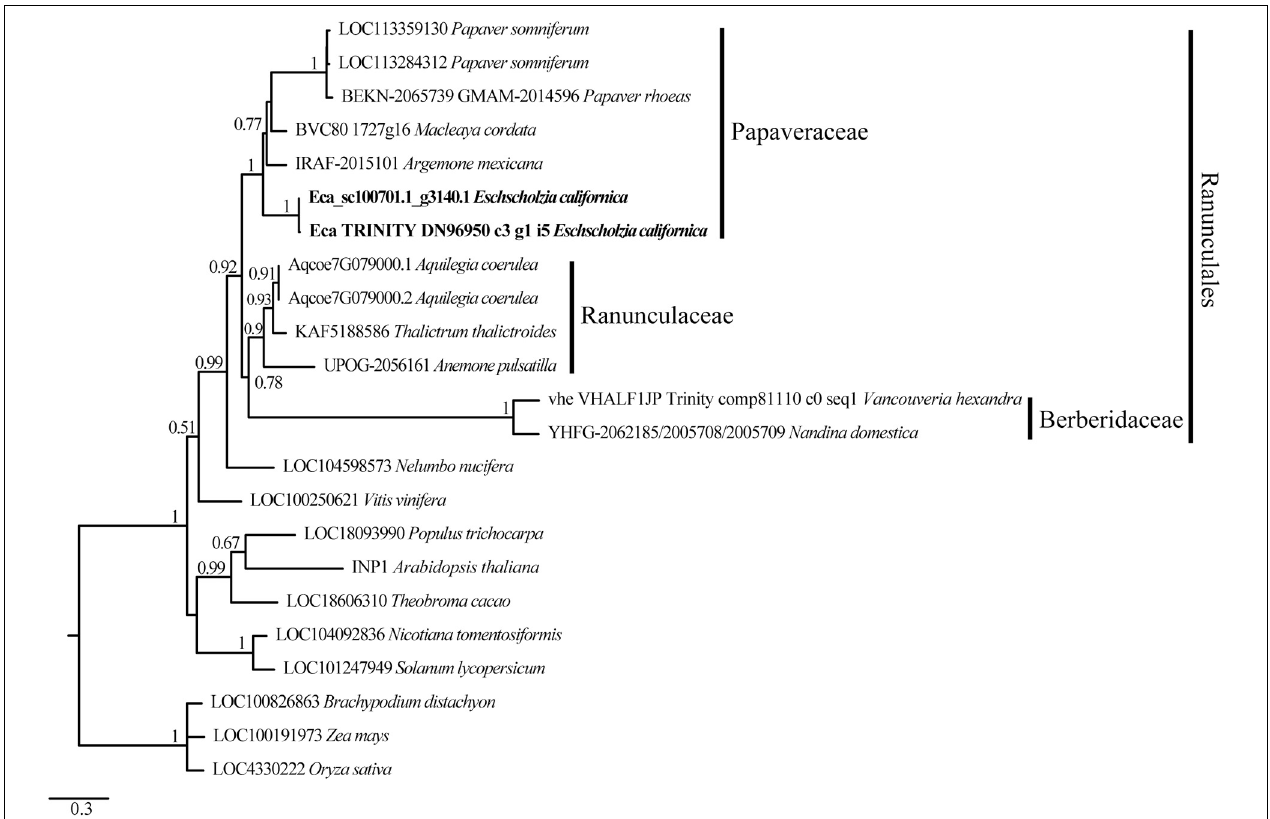
FIGURE 1 | Maximum likelihood phylogenetic tree of INP1-like protein sequences showing EcINP1 homology relationships of Eschscholzia californica . The name of each sequence is composed of the locus identifier followed by the species name. Sequence accession numbers can be found in Supplementary Table 2 . The EcINP1 sequences representing two protein isoforms are in bold type. The families to which the selected sequences from the order Ranunculales belong are indicated on the